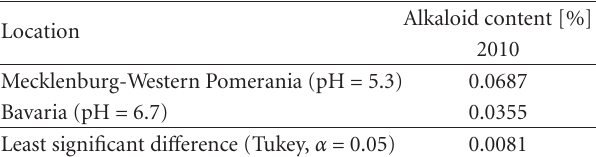
Table 5: Mean alkaloid content estimated on soil with pH = 5.3 and pH = 6.7 observed in actual varieties and breeding lines of Lupinus angustifolius L . at di ff erent locations (2010, n = 32).